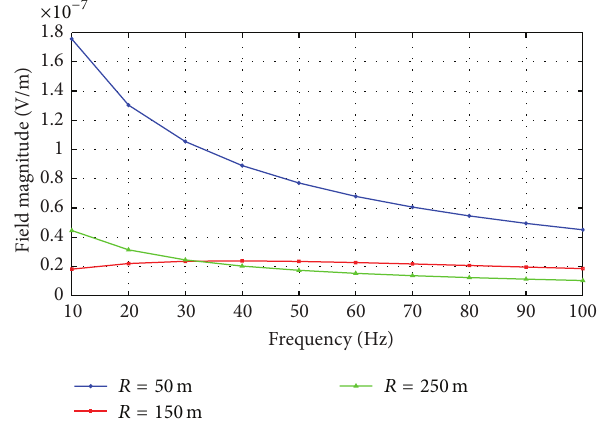
Figure 13: Curves of the radial component of the electric field magnitude with the